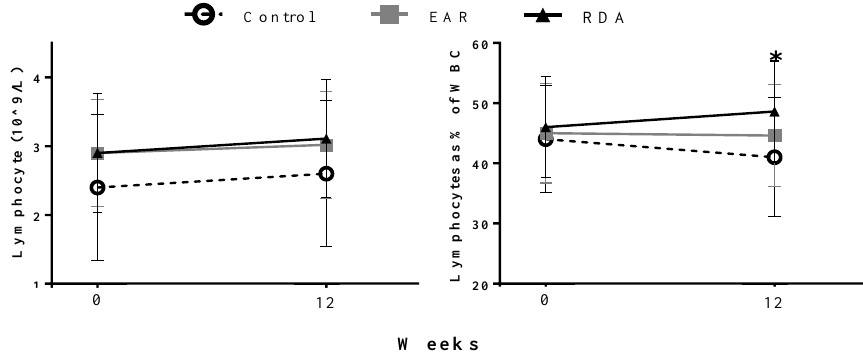
Figure 2. Lymphocyte concentration (reference range: 2.00–8.00 × 10 9 /L) and lymphocyte percentage of total white blood cell (WBC) concentration (reference range: 36–52%) comparison between groups from the 12 weeks trial. Data are mean ± SD using mixed model ANOVA, adjusted for age, sex, BMI z -score, and ethnicity. EAR: Estimated Average Requirement, RDA: Recommended Dietary Allowance. * Significantly different from control group at the same time point p < 0.05. Table 3. Vitamin D status and white blood cell fraction concentrations (10 9 /L) of groups from 6–8 years old subset of 12 weeks winter trial.